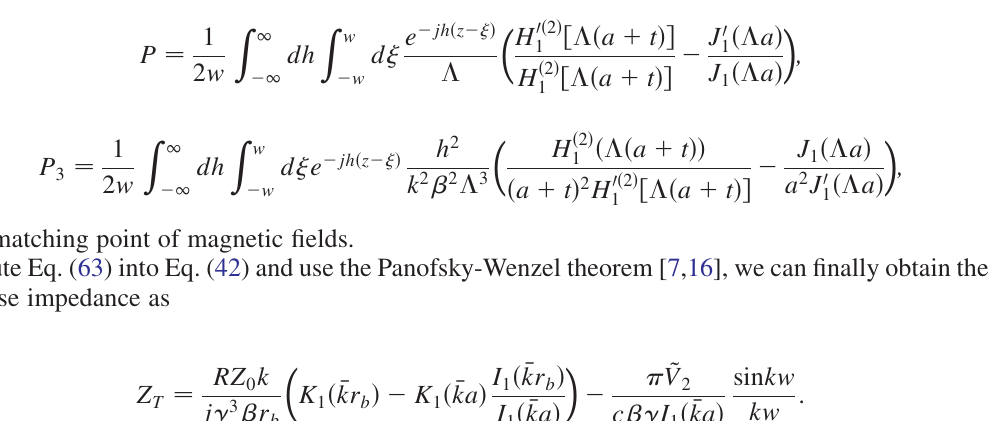
ffiffiffiffiffiffiffiffiffiffiffiffiffiffi p jk(cid:4)Z 0 (cid:1) c